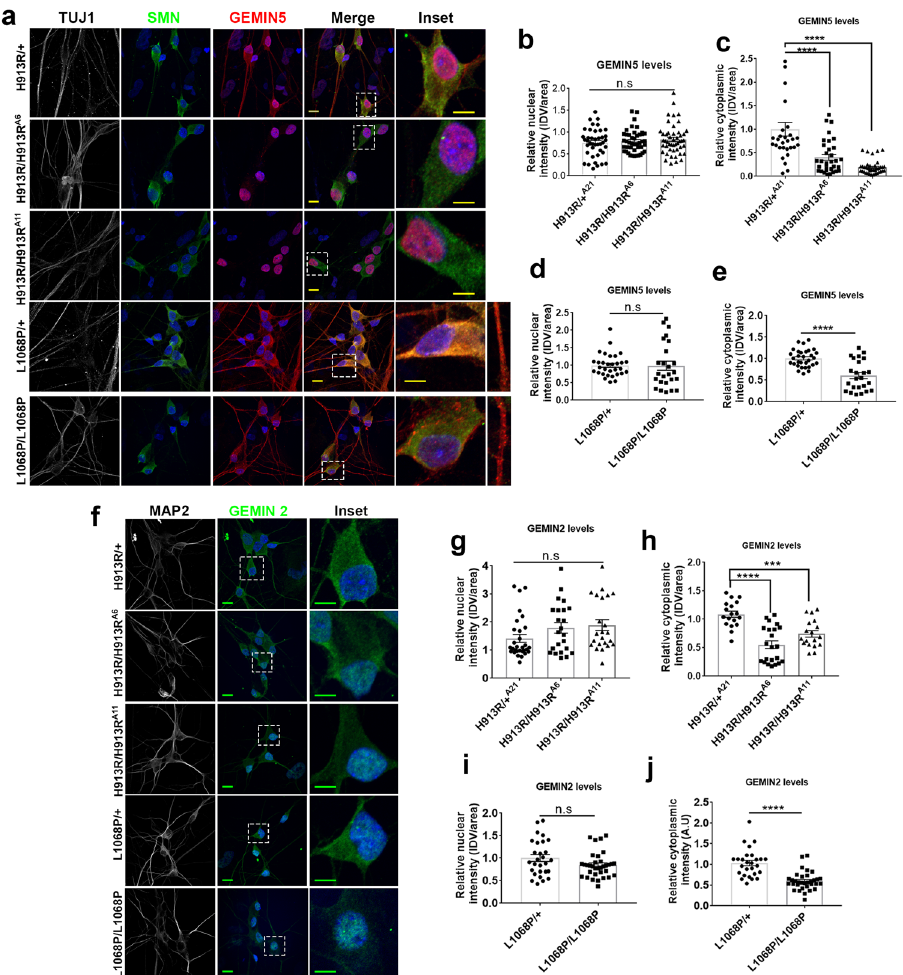
Fig. 2 Differential subcellular expression of SMN assembly proteins in iPSC-derived neuronal cells carrying His913Arg and Leu1068Pro GEMIN5 variants. a Representative Immuno fl uorescence (IF) images showing the sub-cellular mislocalization of GEMIN5 in IPSCs derived neuronal cells carrying p. His913Arg and p. Leu1068Pro hetero- and homozygous variants. H913R/H913R A6 and H913R/H913R A11 were the two isogenic iPSC clones for H913R homozygous variant used in the study (scale bar = 10 µ m). b , c Quantitative analysis displaying the changes in nuclear ( b ) cytoplasmic ( c ) distribution pattern of GEMIN5 as in ( a ), measured as integrated density values (IDV) in H913R hetero and homozygous neuronal cells (one-way ANOVA- Bonferroni test, n = 30 – 40). d , e Quantitative analysis showing the nuclear ( d ) cytoplasmic ( e ) distribution of GEMIN5 as in ( a ) in L1068P hetero and homozygous neuronal cells (two tailed Mann – Whitney U test, n = 25 – 30). f Representative IF images showing the differential subcellular pattern of GEMIN2 in IPSCs- derived H913R and L1068P neuronal cells (scale bar = 10 µ m). g – j Quantitative bar plot representing the integrated density values of GEMIN2 in the nucleus ( g , i ) and cytoplasm ( h , j ) of H913R ( g , h ) and L1068P ( i , j ) GEMIN5 neuronal cell soma (two tailed Mann – Whitney U test, n ≥ 25). The data are represented as mean ± SEM. P values (****<0.0001, ***<0.001, **<0.01) are of unpaired Student ’ s t test. Source data are provided as a Source Data fi